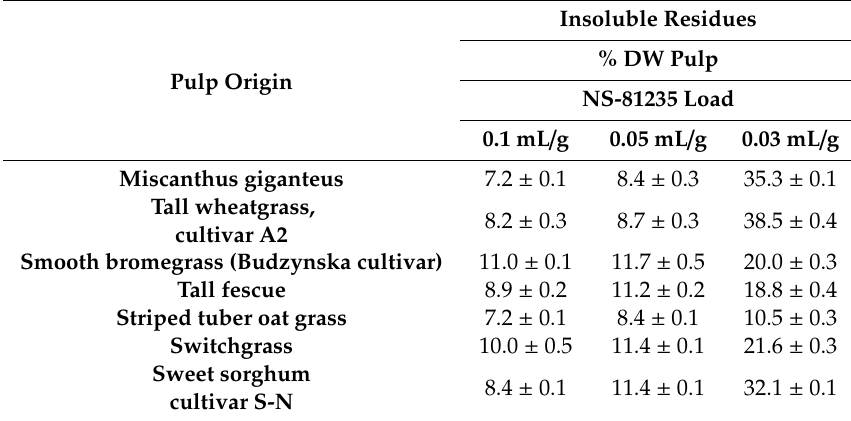
Table 5. The e ff ect of enzyme load on the amounts of insoluble residues that remained after hydrolysis of the kraft